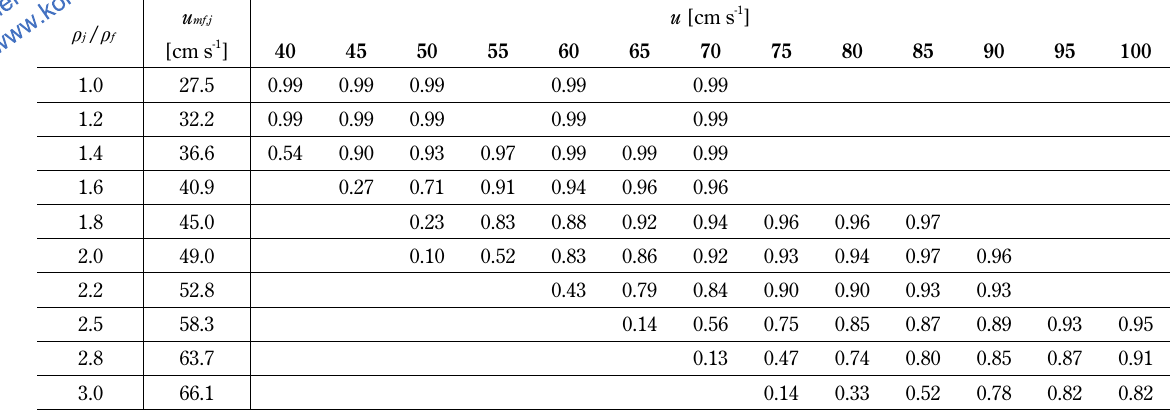
Table 4 Steady-state mixing index values obtained for various density ratios and gas velocities ρ j / ρ